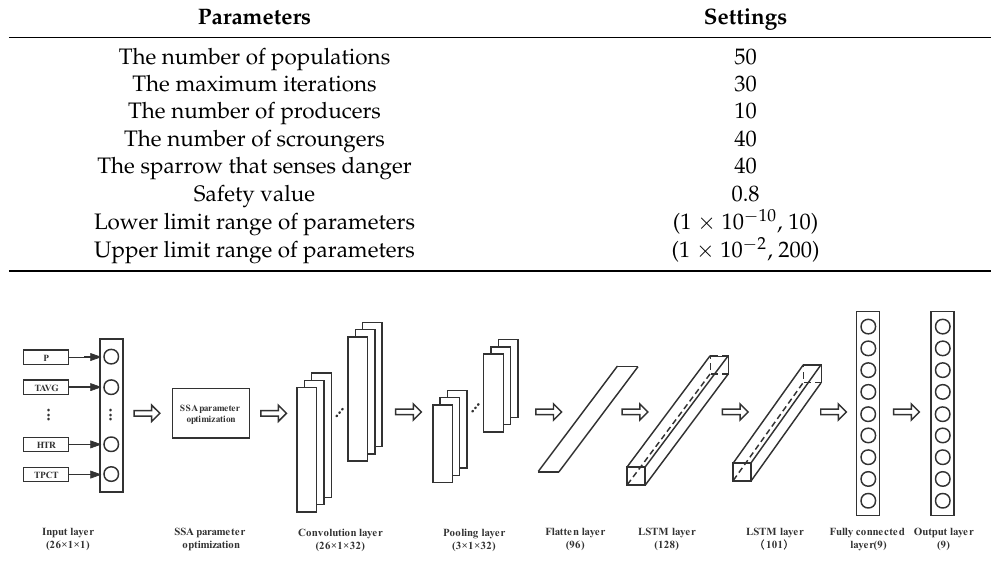
Figure 6. Architecture of the proposed regional SSA-CNN-LSTM model.